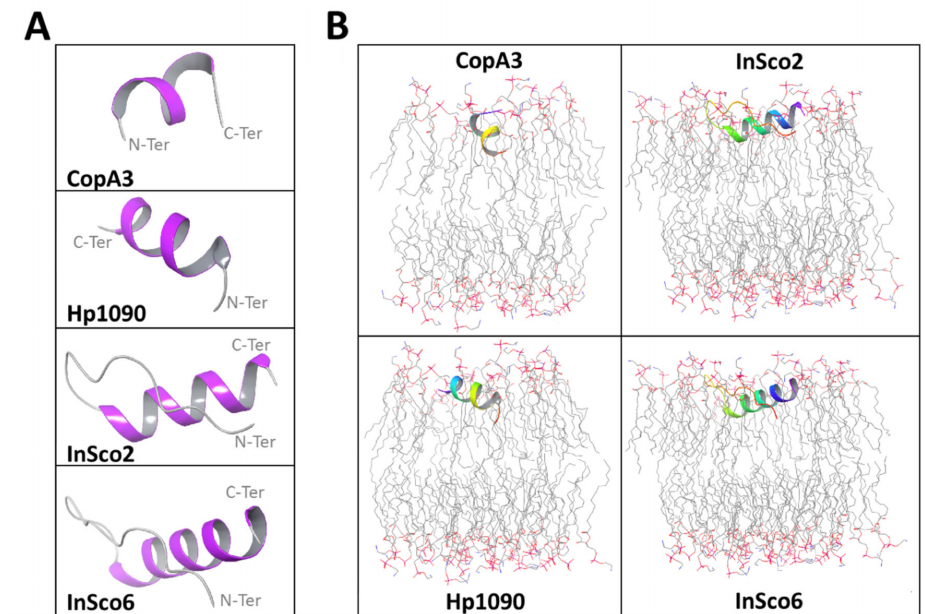
Figure 1. Predicted AMP structures and membrane orientations. The initial conformation of each AMP ( A ) is colored according to the secondary structure fold (gray = coil, purple = α -helix). The AMPs were oriented in a POPE bilayer membrane ( B ) with the termini color coded (red = N-terminus, purple = C-terminus). The POPE membrane atoms are also color-coded (gray = carbon, red = oxygen, blue = nitrogen; hydrogen atoms are not shown).